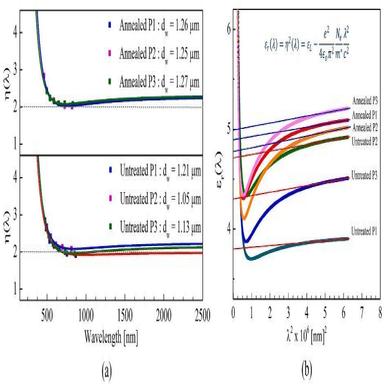
(a) Refractive index evaluated based on the F-PT method at three locations (solid squares) and the fitted Cauchy's dispersion curves (solid lines) and film thicknesses obtained from the F-PT method. (b) Plot of εr(λ) vs λ2 at the three locations of the untreated and annealed films.